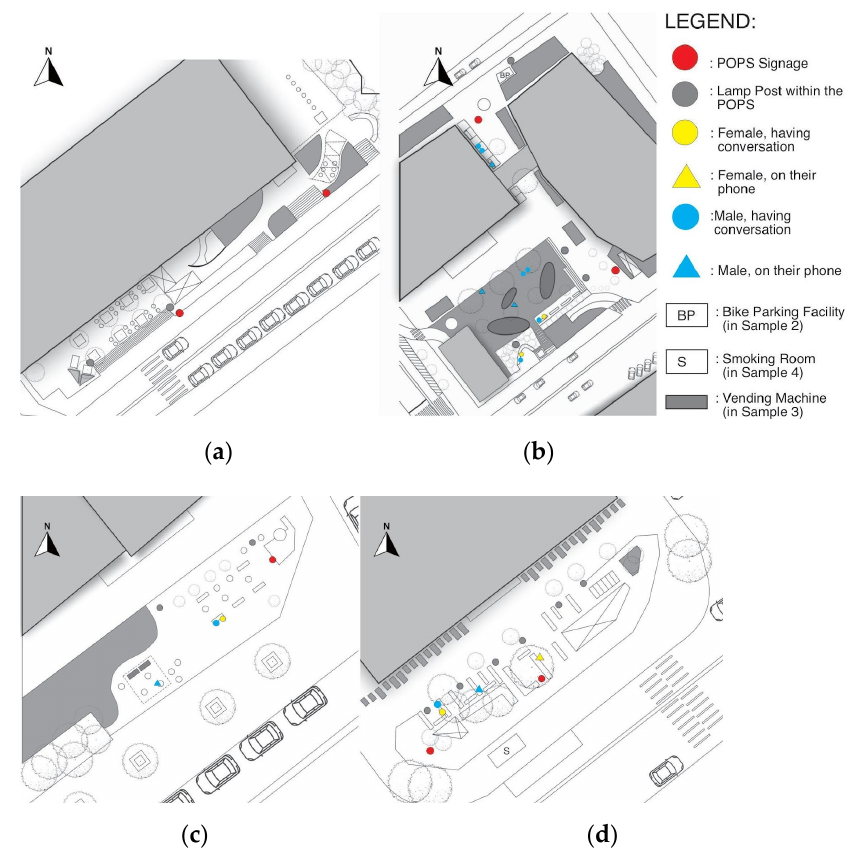
Figure 5. The behavior map of Sample 1 ( a ), Sample 2 ( b ), Sample 3 ( c ), and Sample 4 ( d ) on a Saturday afternoon. Sample 2 and 4 comparably attracts more visitors than Sample 1 and 3. The design of Sample 2 and 4 also shows a more comprehensive layout.